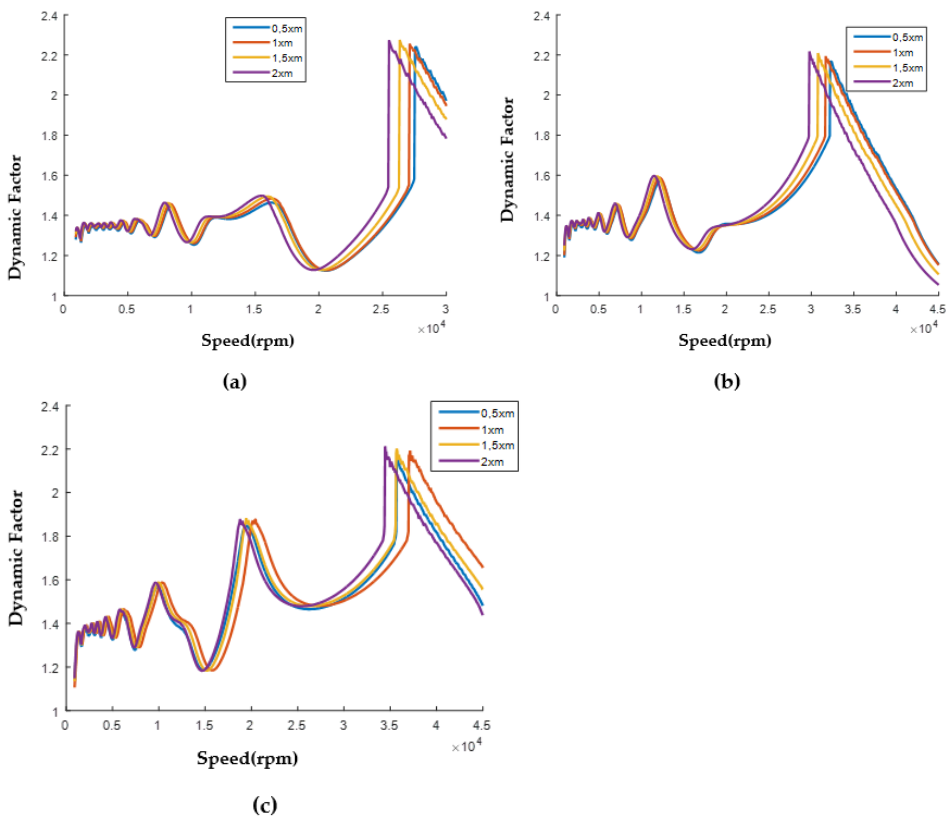
Figure 25. DF results of hybrid gears with different DSPAs; ( a ) 20°, ( b ) 25°, ( c ) 30°.